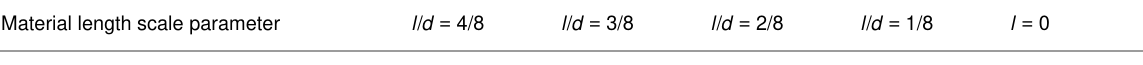
Table 12: Maximum deflection of a polystyrene nanorod in the nonclassical Timoshenko beam model. Material length scale